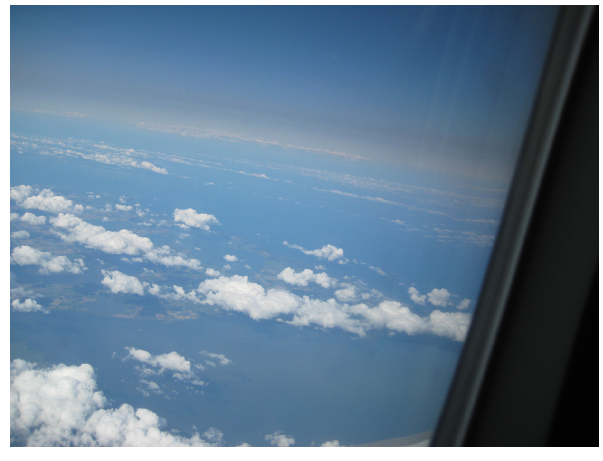
Figure 3. Photograph of the Pagami Creek fire plume taken from DLR Falcon research aircraft over Germany (16 September 2011, 12:11UTC;